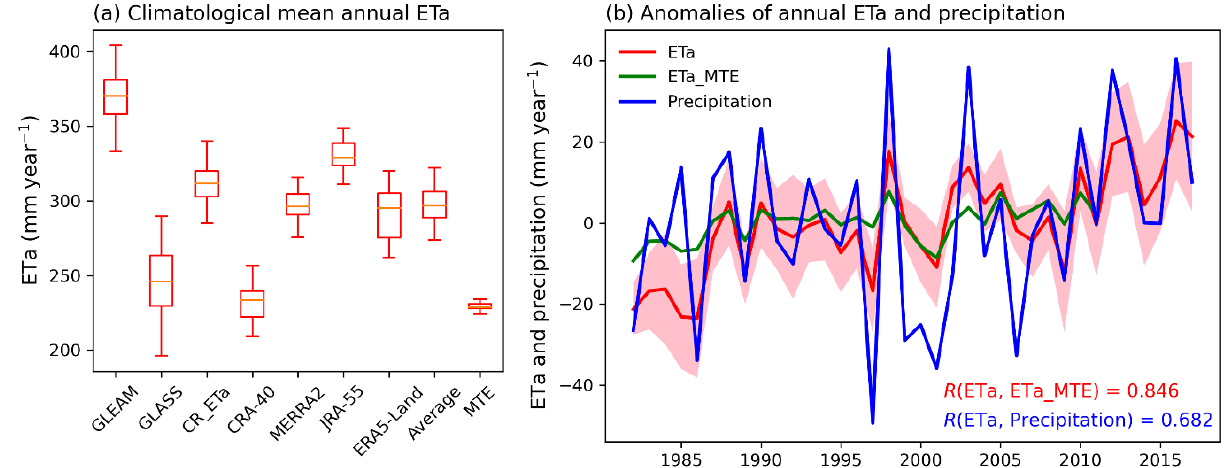
Figure 3. ( a ) Boxplots of the area-averaged annual ETa for GLEAM, GLASS, CR_ETa, MERRA2, ERA5- Land, CRA-40, JRA-55, the average of seven datasets (Average), and FLUXNET-MTE (MTE) in north- ern China; ( b ) annual anomaly time-series of area-averaged ETa and precipitation (unit: mm · year − 1 ) in northern China during 1982–2017. The magenta shading indicates one standard deviation up and down among different ETa datasets. R denotes Pearson correlation coefficient between ETa, ETa_MTE, and